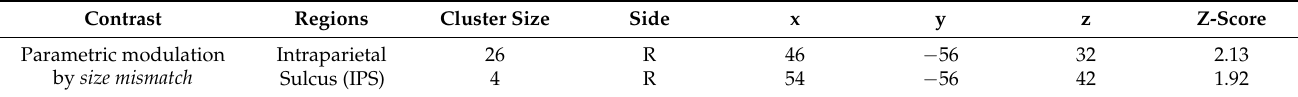
Table 2. Results of the second-level analysis of Experiment 2. Coordinates were defined within MNI space, and activations were all significant at p < 0.05 (uncorrected) with a one tailed test using a region-of-interest-based approach with an inclusive mask derived from Experiment 1 (cluster in Table